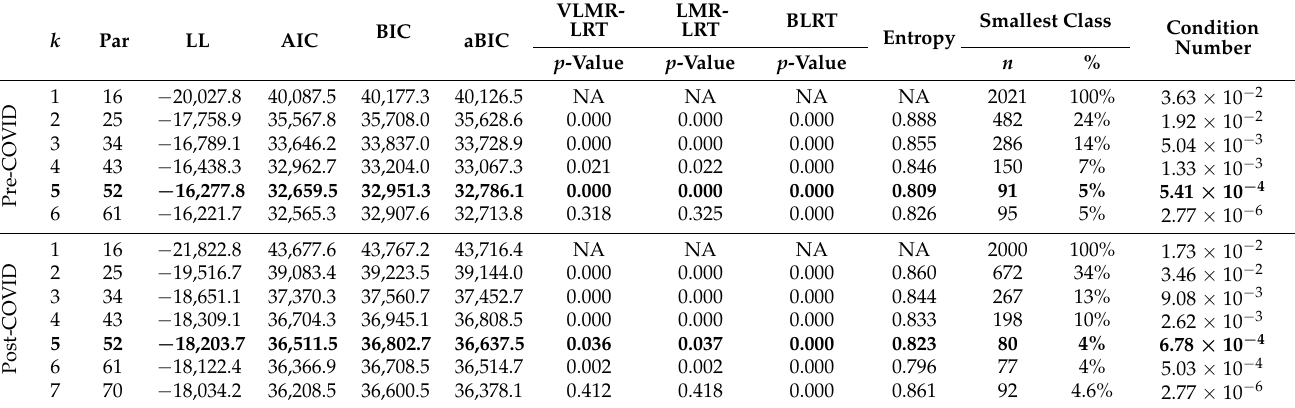
Table 3. Fit indices for unconstrained pre-COVID and post-COVID LPA